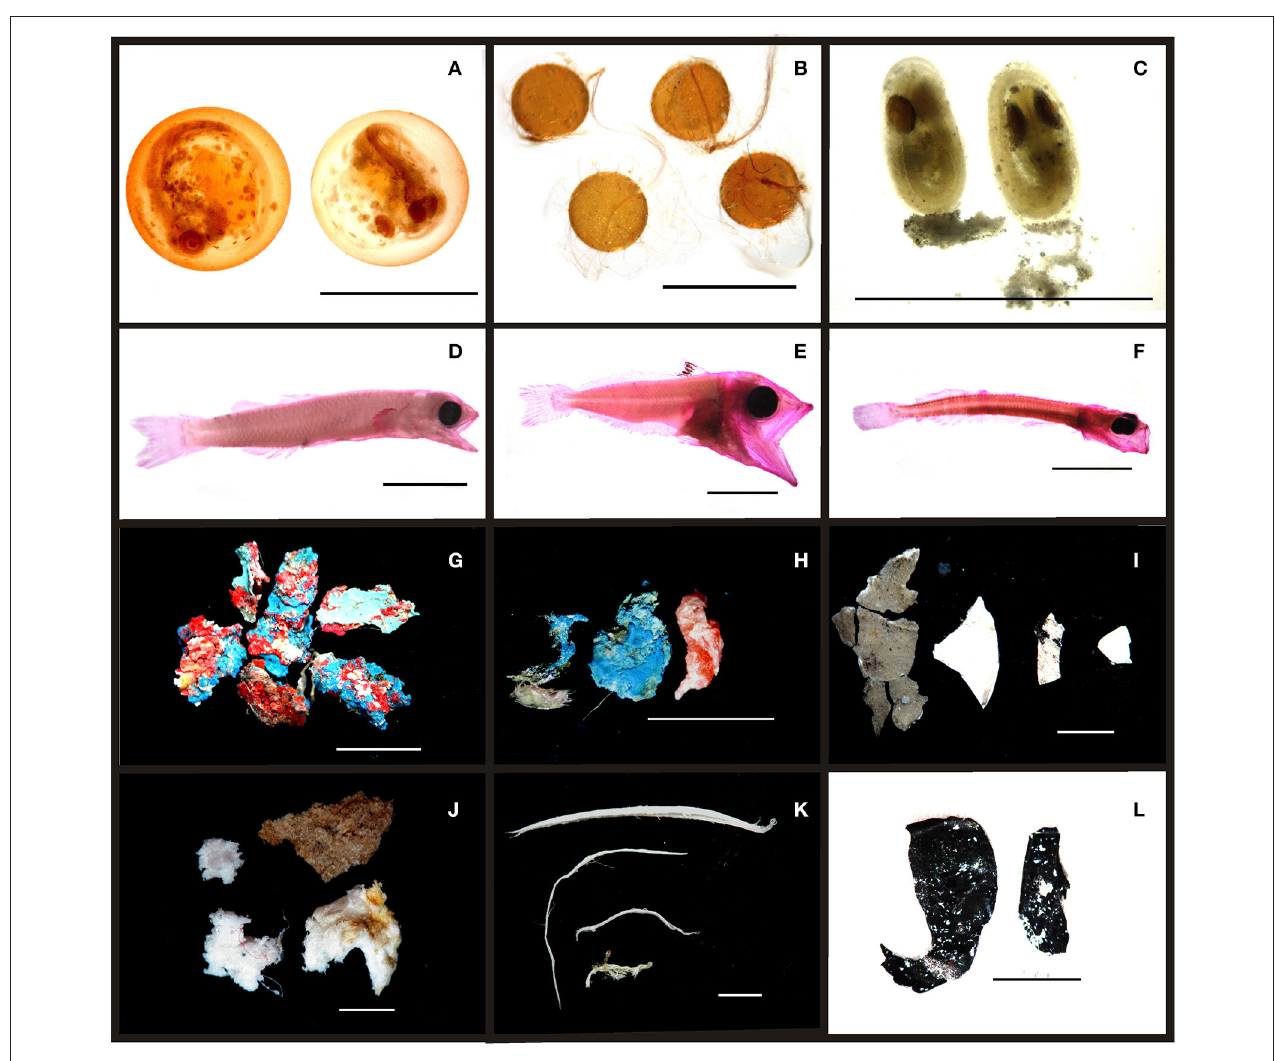
FIGURE 3 | Examples of ichthyoplankton and plastic debris in Saint Peter and Saint Paul Archipelago. (A) Trachpteridae eggs; (B) Exocoetidae eggs; (C) Pomacentridae eggs; (D) Ceratoscopelus warmingii ; (E) Thunnus obesus ; (F) Oxyporhamphus micropterus ; (G) paint chips; (H) hard plastics; (I) soft plastics; (J) rubber cumber; (K) threads; (L) soft